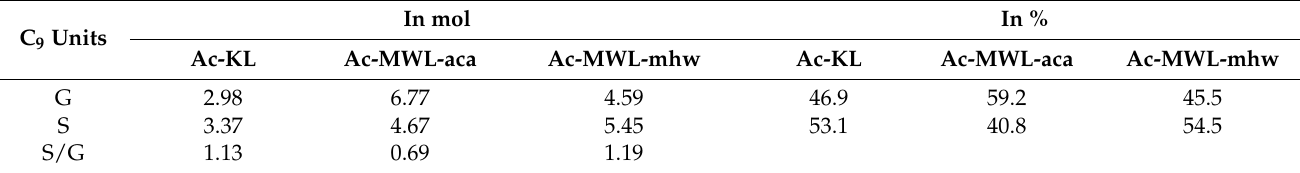
Table 7. Estimation of S units, G units, and S/G ratio in terms of moles and